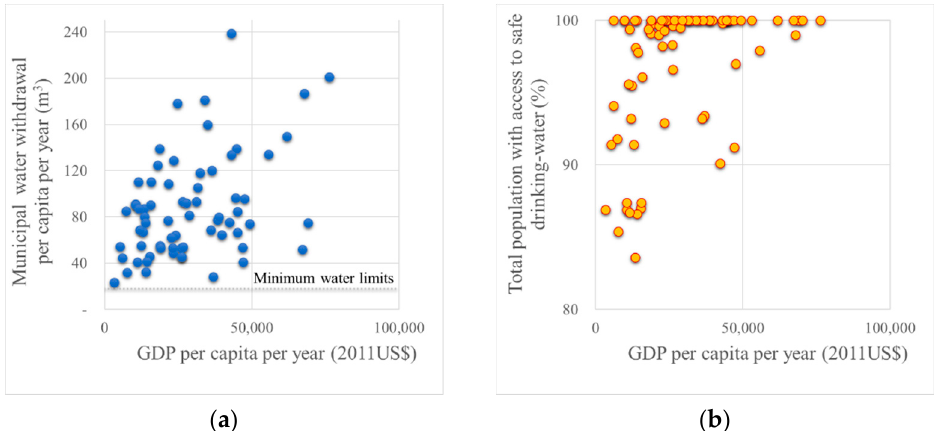
Figure 3. GDP per capita per year related to: ( a ) municipal water withdrawal per capita per year, average per country in 2018; ( b ) access to safe drinking water, average per country in 2018 [64,65].